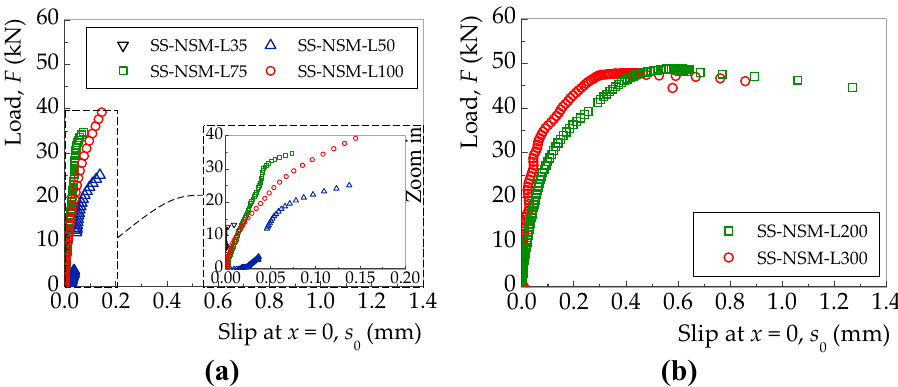
Fig. 9 Load–slip responses of the NSM samples with: a a short bond length; and b a long bond length.